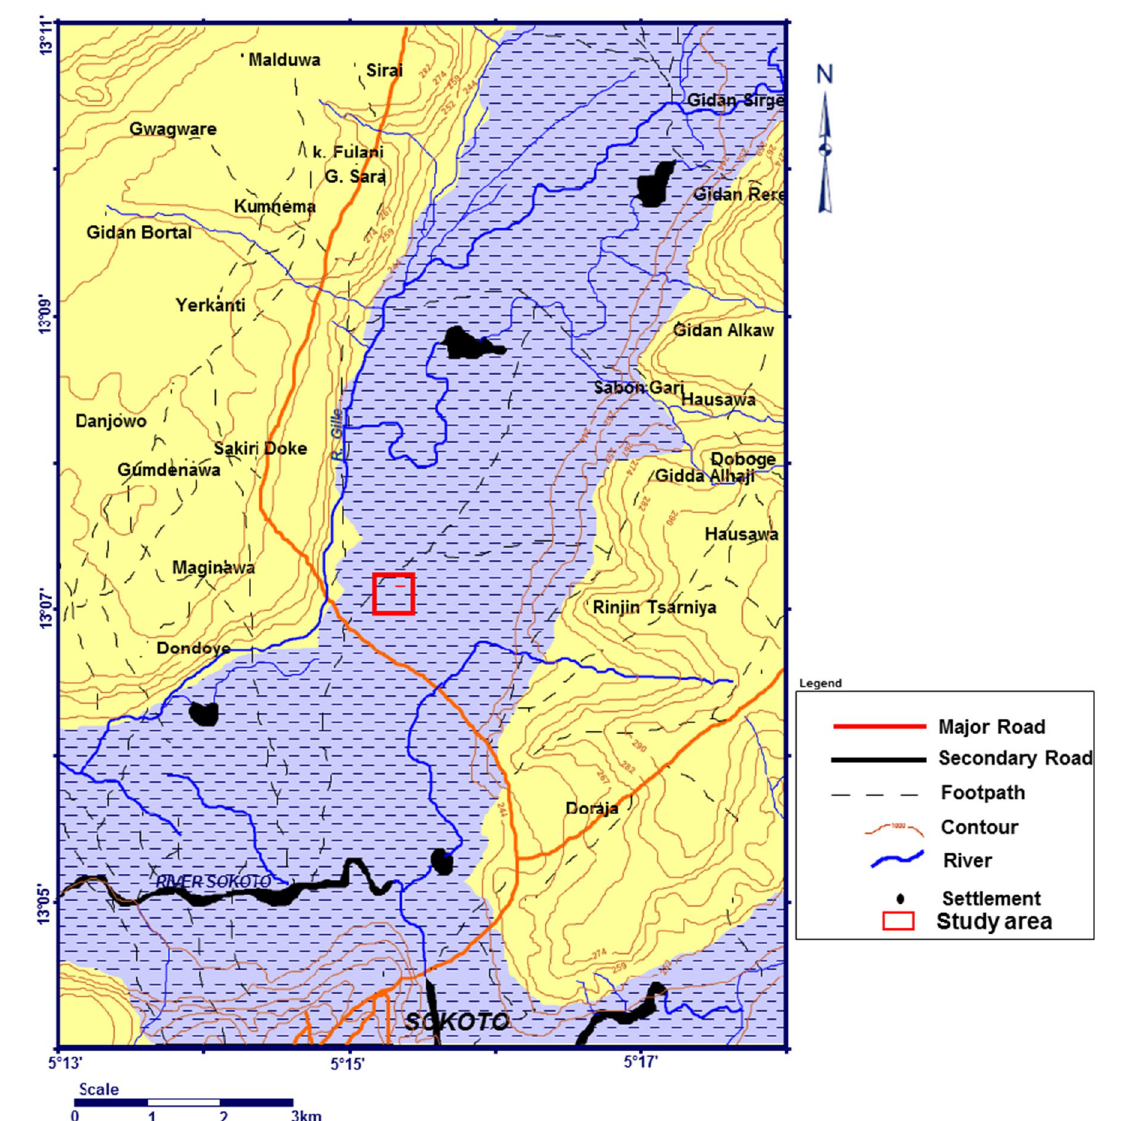
Fig. 1 Topographical map of part of Sokoto showing the study area (NGSA flaser bedding (also characteristic of the Taloka Formation).